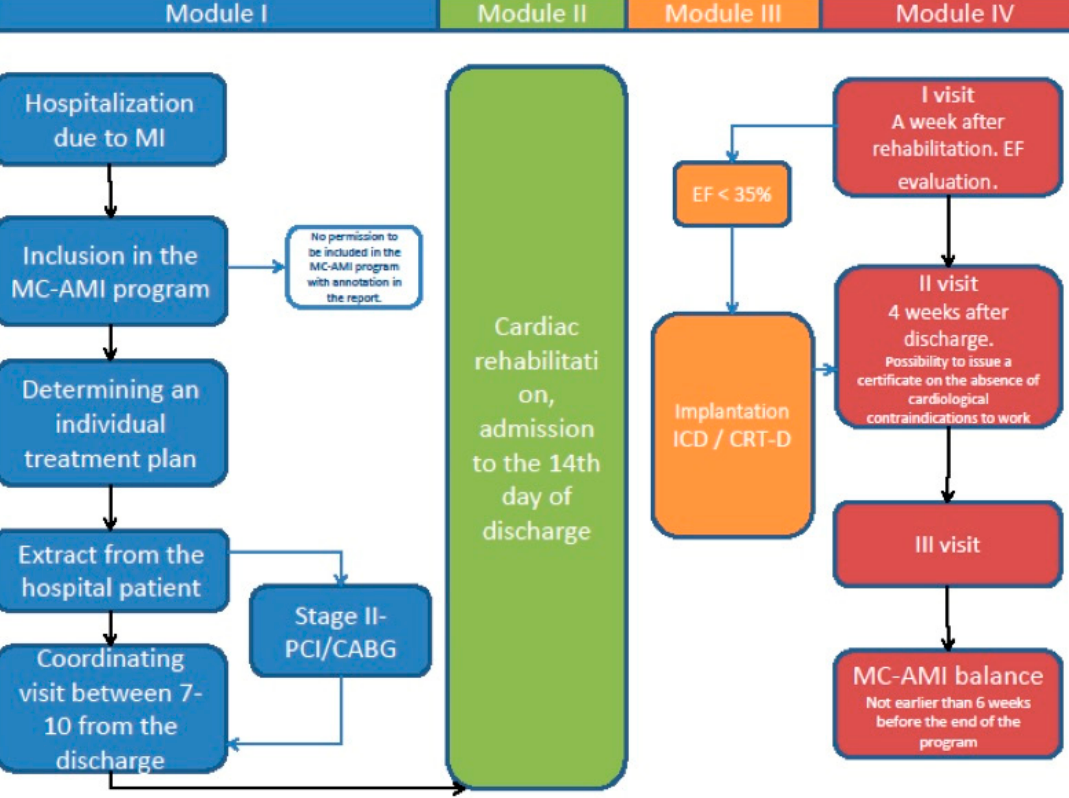
Figure 1. Study flowchart. MC-AMI: Managed Care in Acute Myocardial Infarction, PCI: percutaneous coronary intervention, CABG: coronary artery by-pass grafting, ICD: implantable cardioverter defibrillator, EF: ejection fraction, CRT-D: cardiac resynchronization therapy- defibrillator.